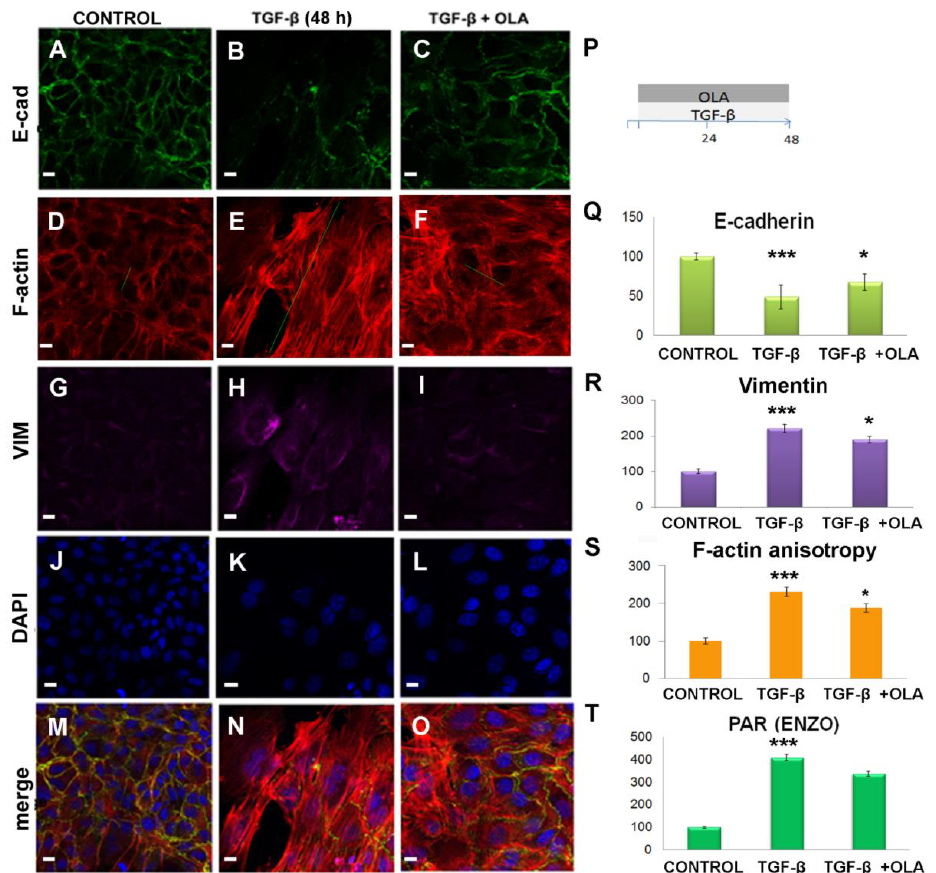
Figure 2. OLA prevented EMT-associated morphological changes, E-cad decrease, and VIM increase. NMuMG cells were treated with TGF- β (5 ng/mL) for 48 h in the presence or absence of 50 nM OLA and the effects were evaluated by ICF ( A – O ) and image quantification ( Q – T ). All images are confocal single planes and have undergone a Gaussian blur with ratio = 1. Columns correspond to control ( A,D,G,J,M ), TGF- β ( B,E,H,K,N ) and TGF- β + OLA ( C,F,I,L,O ) treatments. Rows display E cad ( A – C ), F-actin detected with phalloidin-rhodamine ( D – F ), VIM ( G – I ), DAPI counterstain ( J – L ), and merged channels ( M – O ). Bar: 10 µm. The green lines represent the direction and magnitude of F-actin anisotropy. The experimental schedule is represented in ( P) , where the blue arrow represents time axis (h). After 4 h serum deprivation, TGF- β and OLA were added simultaneously as a continuous 48-h treatment. Not only typical EMT markers E-cad ( Q ) and VIM ( R ) but also morphological changes ( S) were significantly affected by a low OLA concentration that showed a total PAR diminution tendency ( T ). PAR (n > 70 planes from 10 stacks) and E-cadherin (n > 150 planes from 20 stacks) data are from four independent experiments. VIM (n > 98 planes from 10 stacks) was quantified in three independent experiments. All intensity data were processed as the percentage control of the corresponding experiment and are expressed as the mean percentage control ± SEM. F-actin anisotropy data are from three independent experiments. Anisotropy was quantified on 20 control stacks and > 40 TGF- β or TGF - β + OLA stacks, using the three planes of each stack with higher F-actin signal, after subjecting them to one Gaussian blur ( r = 1) filtering operation. Data were processed as absolute numbers and were expressed only for visual clarity as a mean percentage control ± SEM. Statistical comparisons refer to control vs TGF- β (asterisks on TGF- β bars) and to TGF - β vs TGF - β + OLA (asterisks on TGF- β + OLA bars). * p < 0.05, ** p < 0.01, *** p < 0.001.